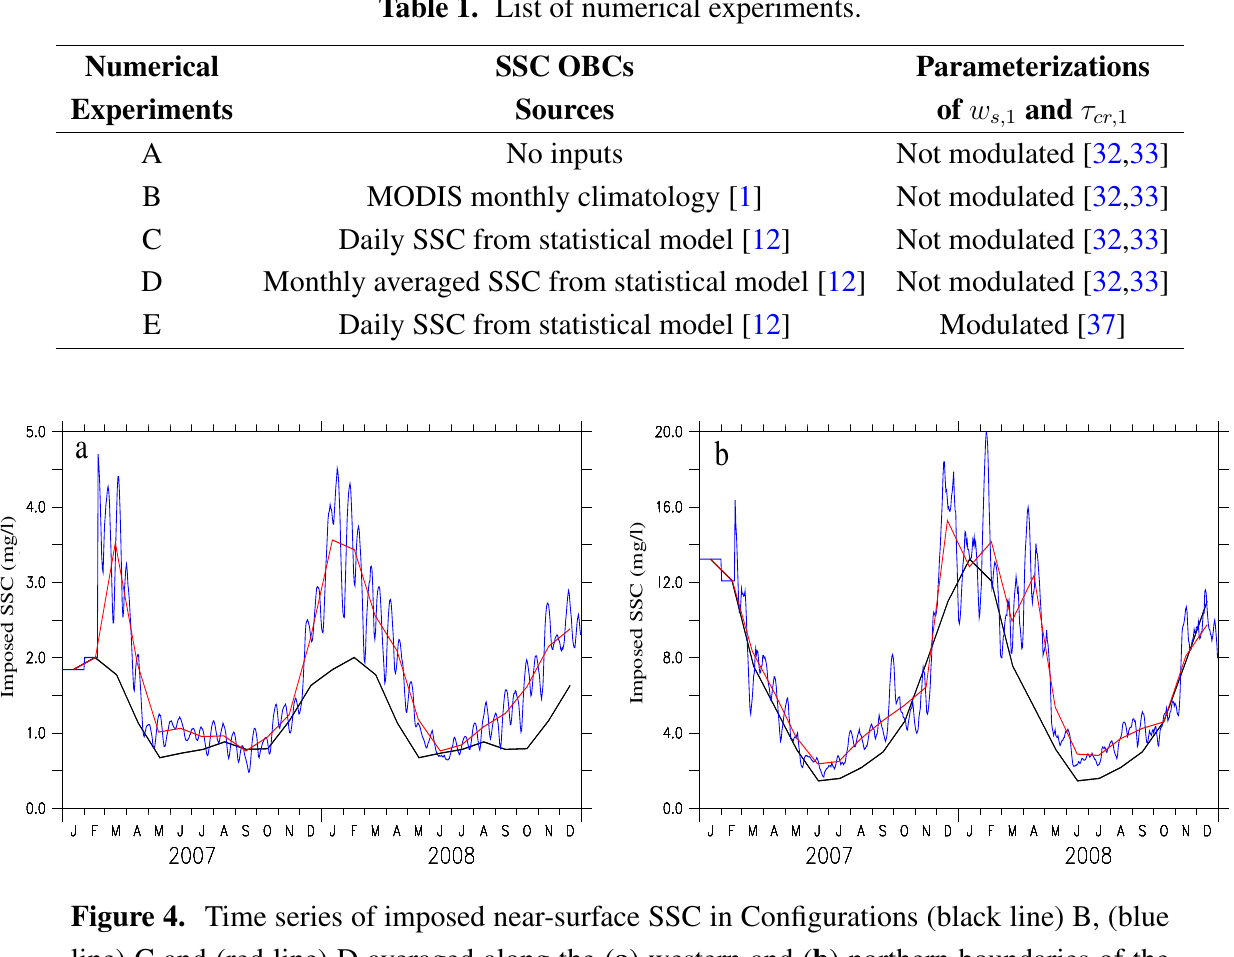
Table 1. List of numerical experiments.